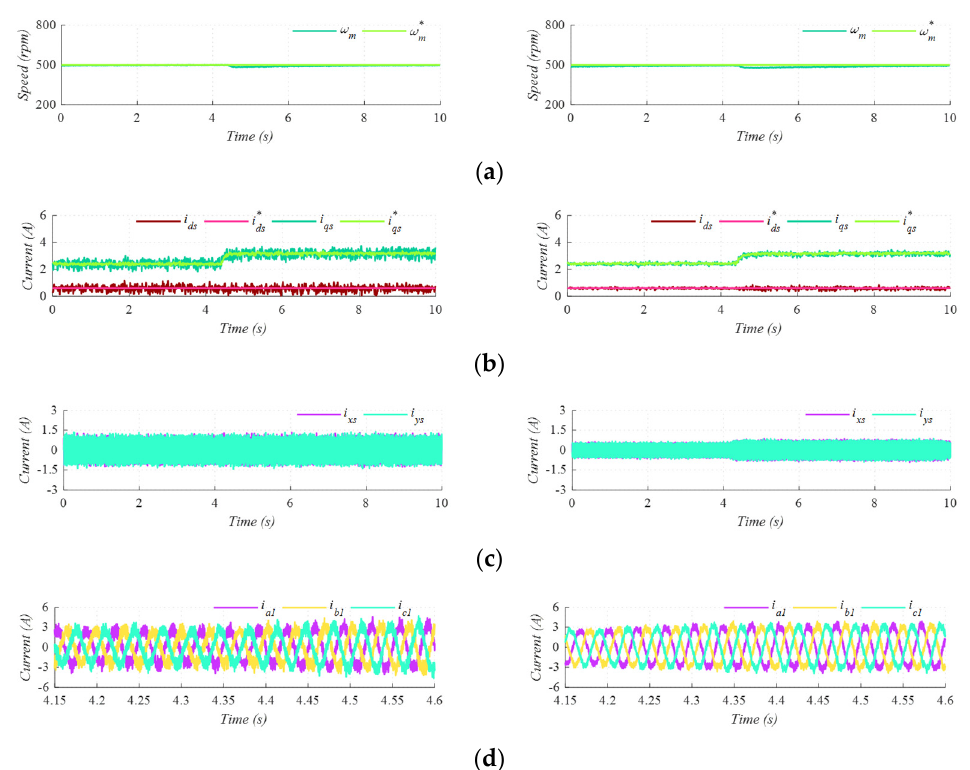
Figure 10. Load torque step test for LVV-MPC (left plots) and PULLA-MPC (right plots). From top to bottom: ( a ) motor speed, ( b ) 𝑑 - 𝑞 currents, ( c ) 𝑥 - 𝑦 currents and ( d ) set 1 of phase currents.